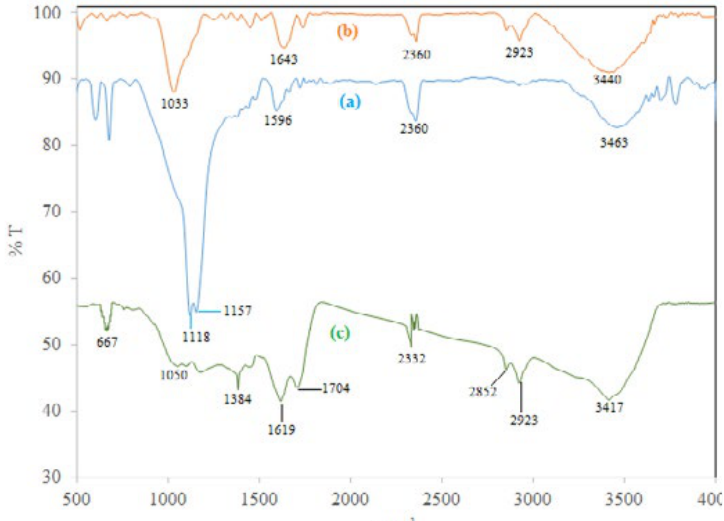
O /AC nanocomposite 3 4